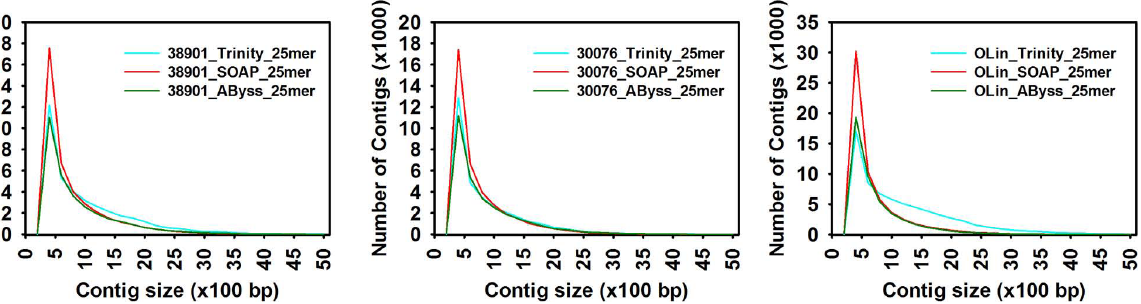
Fig. 1. Contig length distribution generated from Trinity, AByss and SOAP at 25 kmer. Contigs greater than 200 bp were selected. A) 38901, B) 30076 and C)